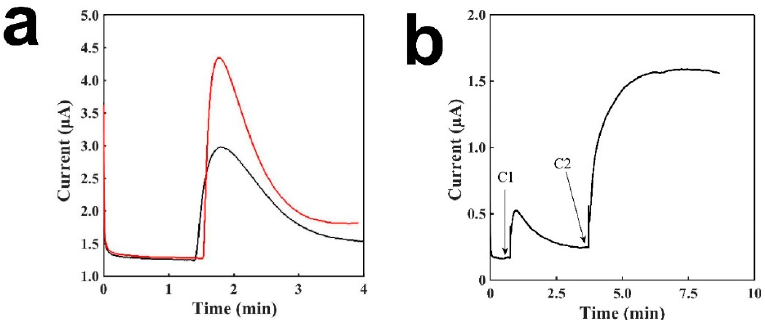
Figure 7. Characterization of the tongue depressor amperometric sensors for saliva. ( a ) The signal of the sensor with enzyme to H 2 O 2 (red) and glucose (black). A total of 5 μ L of 10 mM glucose solution was added to 195 μ L of artificial saliva; ( b ) The signal responses to two different concentrations of glucose in saliva, C1: 0.048 mM and C2: 0.714 mM.